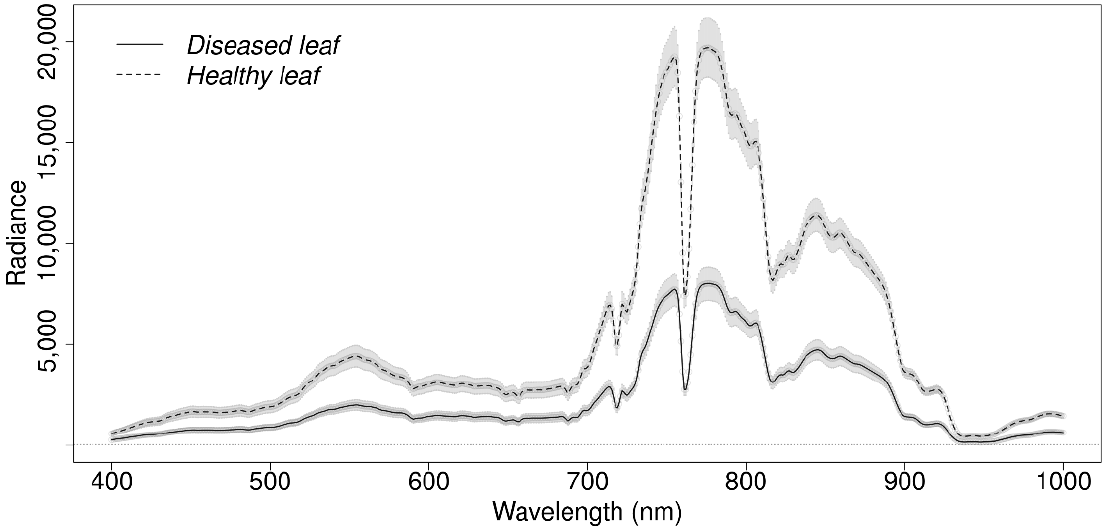
Figure 5. Mean (curved line) and standard deviation (shaded area) radiance of diseased (solid curve) and healthy (dashed curve) oil palm tree samples. In total, 49 diseased and 60 healthy samples were used to derive the statistics.